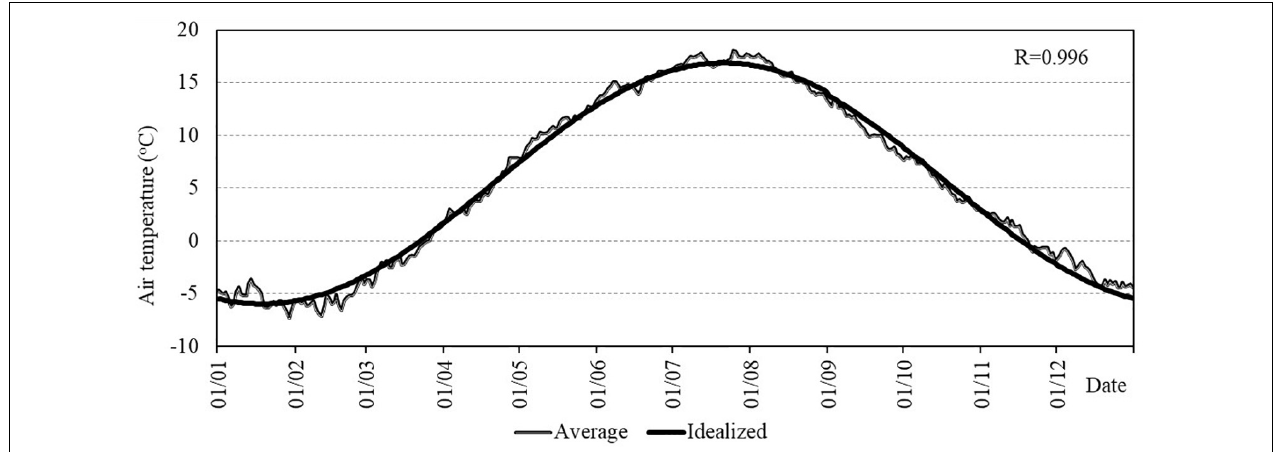
FIGURE 3 | The modeled (idealized) daily average temperature of Türi station for the period 1966–2015 and the daily long-term average temperature of the same period. The correlation coefficient R was found between the model and the average temperature for each calendar day averaged over all years. Türi idealized temperature X was calculated using the following